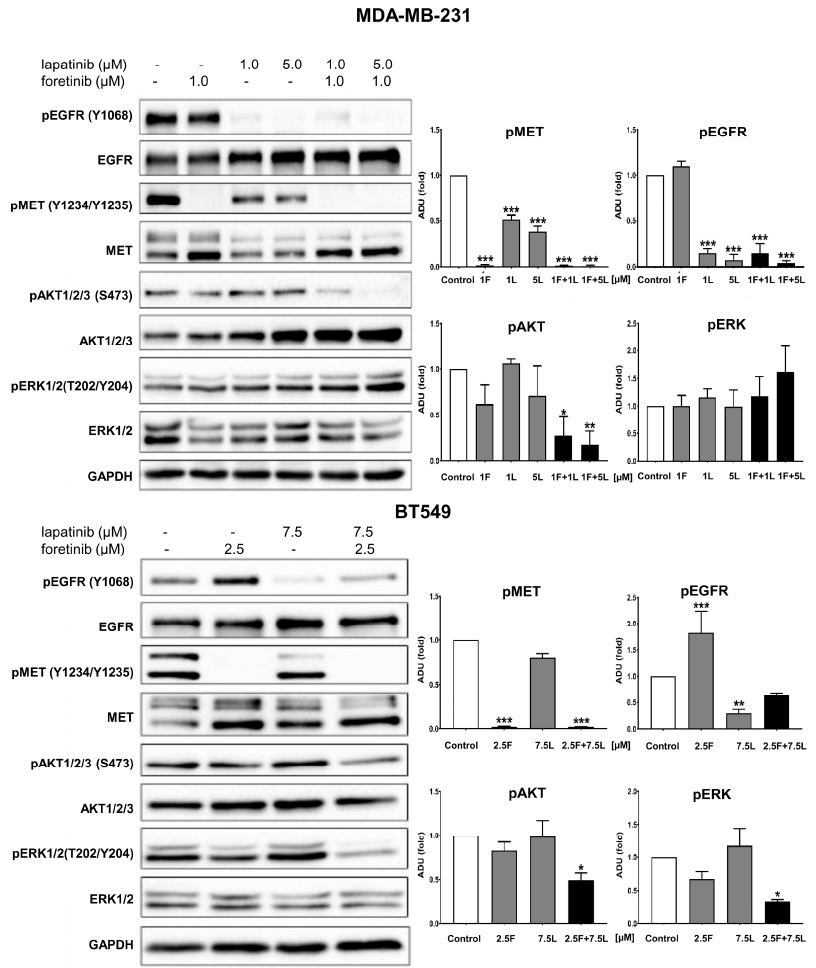
Figure 2. Activation of EGFR, MET, AKT, and ERK in inhibitor-treated TNBC cell lines. Representative immunoblots showing EGFR/pEGFR, MET/pMET, AKT/pAKT, and ERK/pERK levels in cellular extracts of control cells (incubated for 4 h only with 5 nM EGF and 30 ng/mL HGF) and cells treated with HGF, EGF, and the indicated concentrations of foretinib, lapatinib, or their combination. Graphs present densitometric analysis of protein bands for pEGFR, pMET, pERK, and pAKT. ADU stands for arbitrary densitometry units. The densitometry analysis for selected proteins was adjusted using the total protein content. The statistical significance was assessed versus the control. The significance level was set at p ≤ 0.05 (*), p ≤ 0.01 (**), or p ≤ 0.001